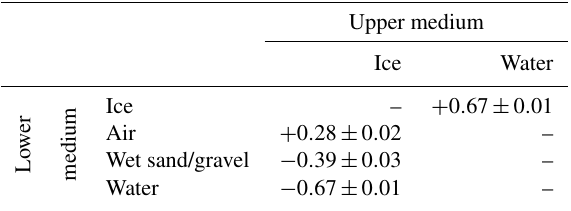
Table 3. GPR reflection coefficients from typical englacial conduit environments using zero-offset